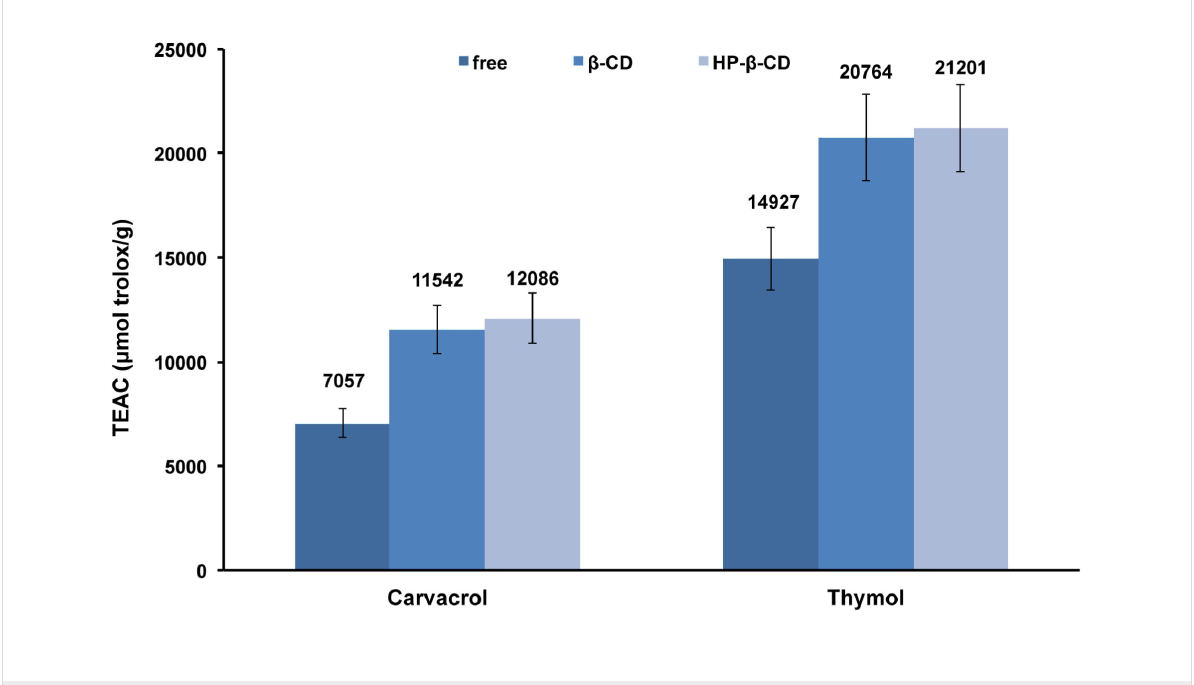
Figure 8: Effects of β -CD and HP- β -CD on the TEAC ( μ mol Trolox/ g of guest) of carvacrol ( 1 ) and thymol ( 2 ) by using ABTS •+